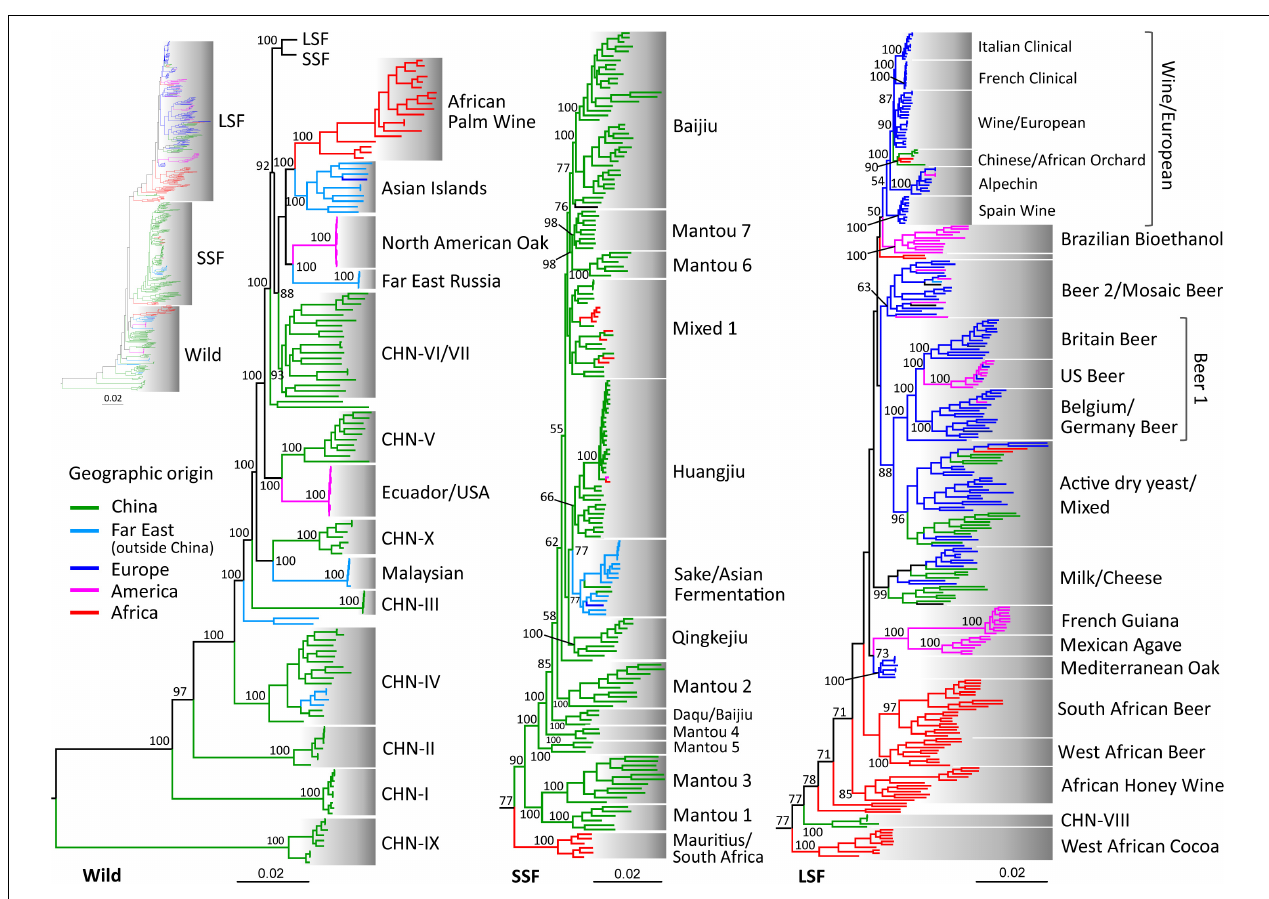
FIGURE 1 | Phylogeny of wild and domesticated isolates of S. cerevisiae inferred from maximum likelihood analysis based on 1,382,078 genome-wide SNPs from 612 isolates with worldwide origins. The tree is rooted by lineage CHN-IX and the bootstrap support values to lineages and major clades above 50% are shown. Strain branches are colored according to geographic origins. LSF, liquid-state fermentation; SSF, solid-state fermentation. Scale bar, 0.02 substitutions per